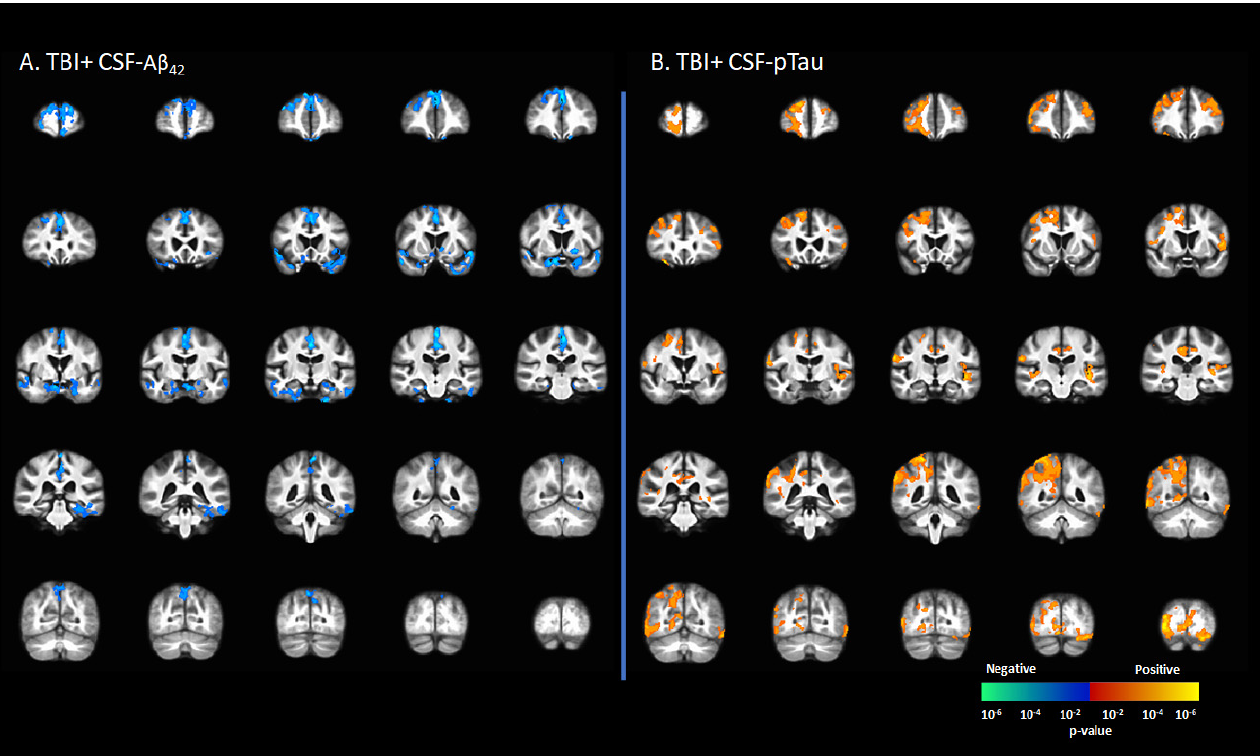
Figure 4. Correlation between [ 18 F]-AV1451 SUVr maps and cerebrospinal fluid (CSF) biomarkers in the population with a self-reported history of traumatic brain injury (TBI), with results showing ( A ) negative correlations between CSF-A β 42 and [ 18 F]-AV1451 SUVr in brain; ( B ) positive correlation between CSF-pTau and [ 18 F]-AV1451 SUVr in the brain. Red-yellow represents a positive correlation between tau accumulation in TBI+ cases and CSF biomarkers, while blue-green represents negative correlation between tau accumulation and CSF biomarkers.